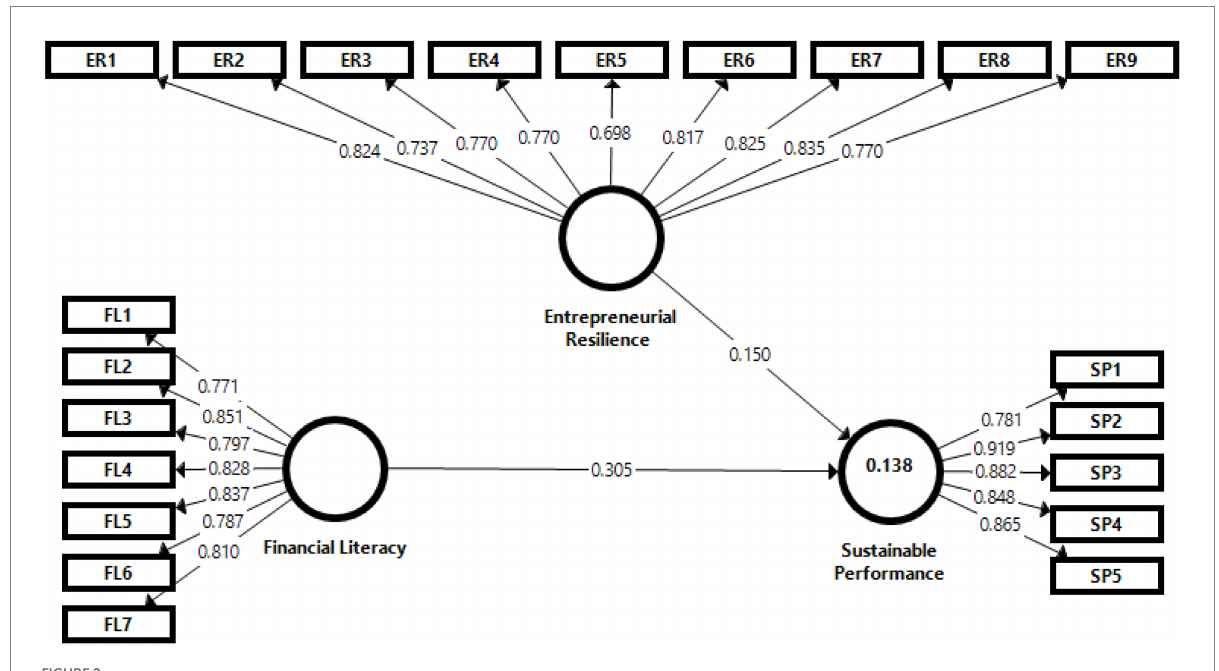
FIGURE 2 Structural model. Authors’ elaboration.